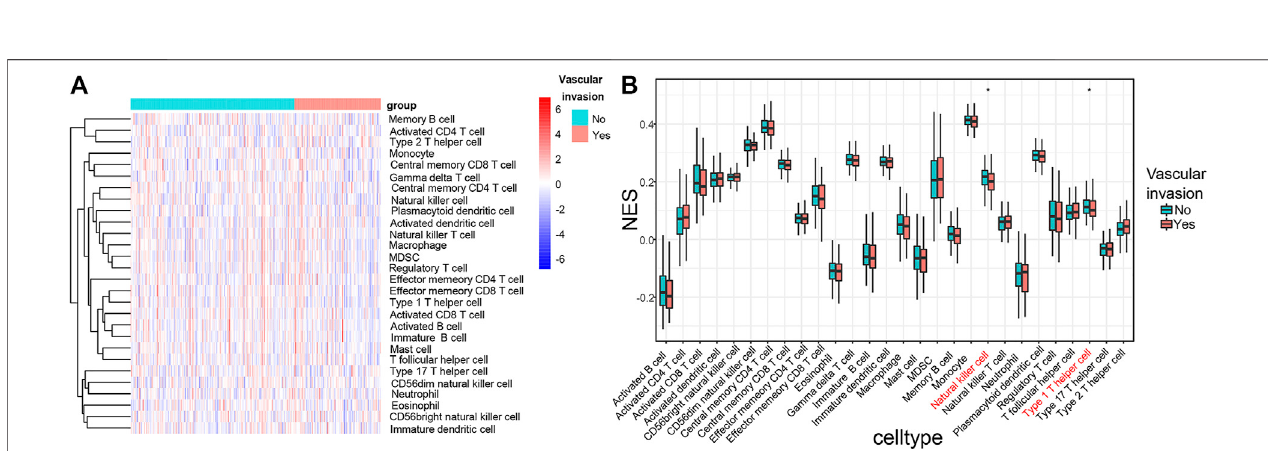
FIGURE 7 | Nomogram for validating the prognostic ef fi ciency of the risk signature. (A) The nomogram was assembled with a risk signature for predicting the survival of patients with HCC. The calibration plots of the nomogram for the probability of OS at 1 year (B) , 3 years (C) , and 5 years (D) .